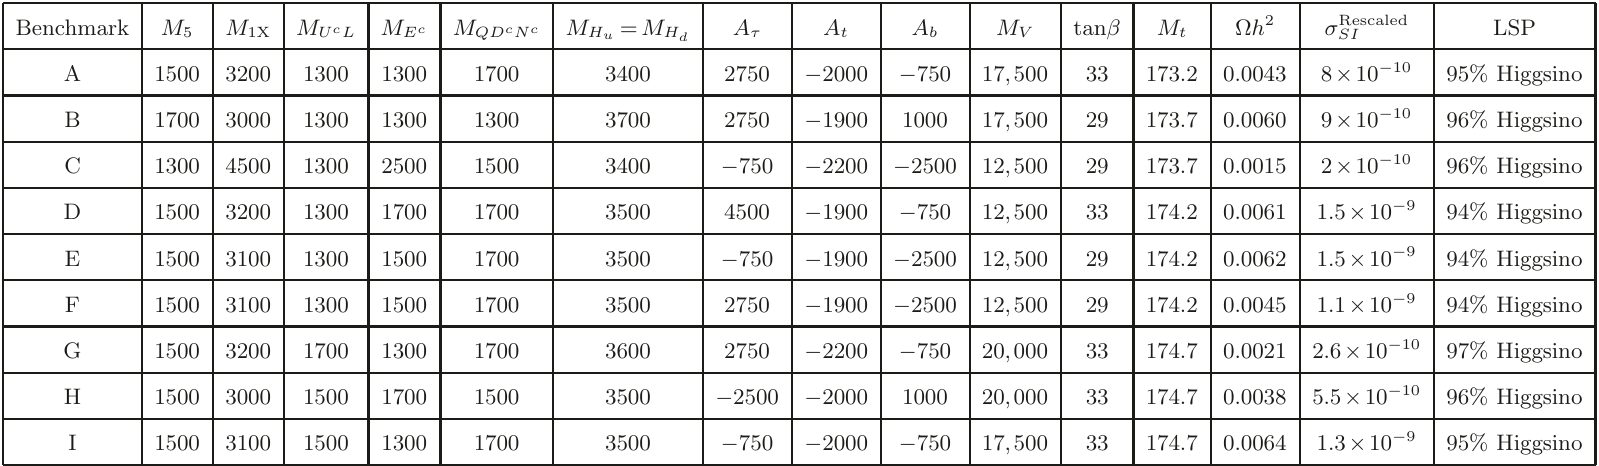
Table 1 . The SUSY breaking soft terms, in addition to the vector-like flippon decoupling scale M V , the low energy ratio of Higgs vacuum expectation values (VEVs) tan β , and top quark mass M t for the -SU(5) D-brane inspired naturalness region. Each benchmark point is identified F with an alphabetical label in order to link the data in table 1 with the data in tables 2–3. All masses are in GeV. The relic density Ω h 2 , rescaled dark matter direct detection cross section σ Rescaled (in pb), and Higgsino percentage of the LSP are also SI